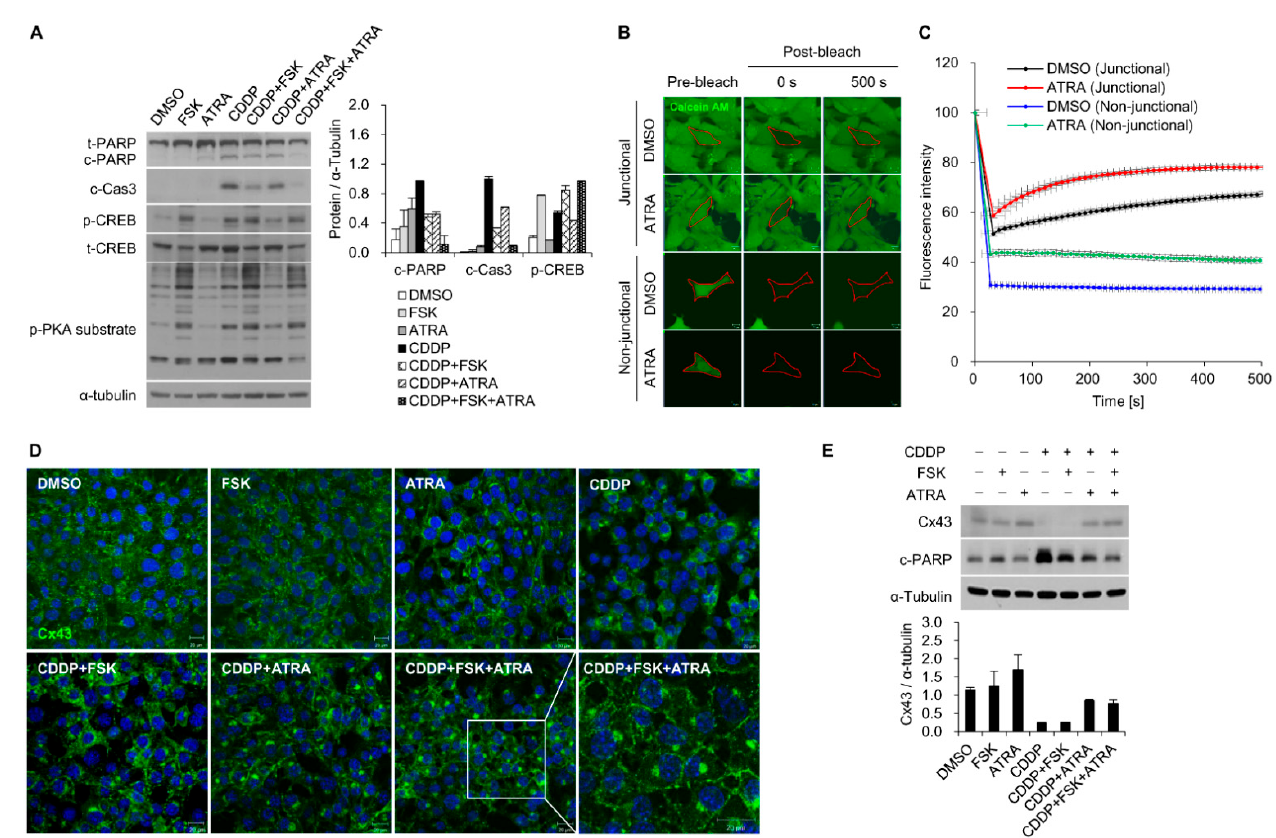
Figure 2. The gap junction enhancer ATRA potentiated the protective effect of FSK against CDDP-induced ototoxicity. ( A ) Western blot and densitometric analyses of PARP, caspase-3, p-CREB, and p-PKA substrate. p-CREB was normalized to total CREB, while cleaved PARP and caspase-3 were normalized to α -tubulin levels. Organ of Corti primary cells were treated with 25 µ M FSK and 50 µ M ATRA with or without 25 µ M CDDP for 24 h. ( B ) FRAP assay of gap junction activity. HEI-OC1 cell monolayers were incubated in calcein AM (2 µ M, 10 min, green) and photobleached with a laser. Recovery of fluorescence in the photobleached cells was monitored every 10 s for 500 s. The region of bleaching is indicated with red dotted lines. Representative confocal micrographs obtained prior to bleaching, immediately after bleaching (0 s), and after recovery (500 s) of HEI-OC1 cells in contact (junctional) and non-contact (non-junctional) conditions that were treated with ATRA (50 μ M, 4 h). Scale bar = 10 μ m. ( C ) Summary of the time course of FRAP data for at least three individual cells. For all bleached cells, the fluorescence signals present in each cell immediately before photobleaching were normalized to 100%. ( D ) Representative confocal images and ( E ) Western blot of Cx43 in HEI-OC1 cells after treatment with DMSO, FSK, and ATRA with or without CDDP for 24 h. The white square on CDDP + FSK + ATRA images indicates the magnified area. Significant differences were found between the four groups CDDP, CDDP + FSK, CDDP + ATRA, and CDDP + FSK + ATRA (* p < 0.05).